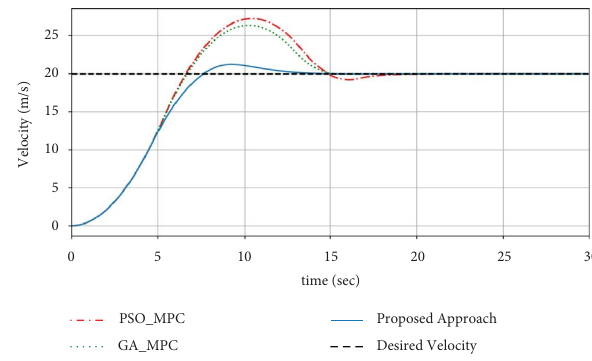
Figure 4: Speed control.